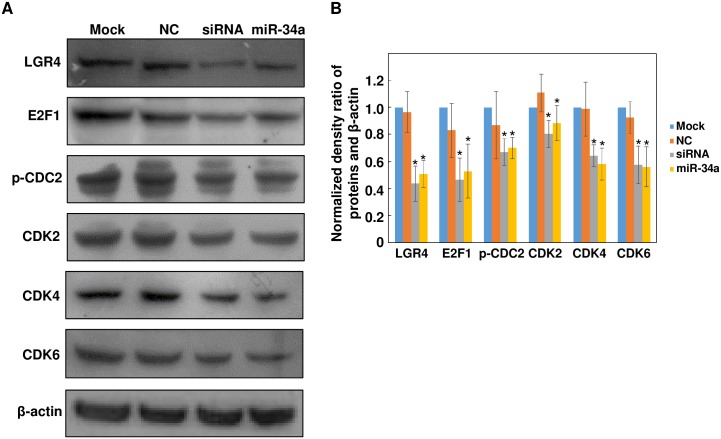
Knockdown of LGR4 downregulates the expression of cell cycle-related molecules reminiscent of miR-34a mimic transfection.(A) After transfection with either LGR4 specific siRNA or miR-34a mimic, ARPE-19 cell lysates were prepared and probed with anti-LGR4, E2F1, p-CDC2, CDK2, CDK4 and CDK6 antibodies. β-actin was probed as a loading control. These results are representative of at least three independent experiments. (B) The band intensity was measured with ImageJ software. The densitometric ratio between proteins of interest and β-actin was calculated and then normalized to the expression level in mock-treated cell. Results were expressed as mean ± SD (n = 3, *p < 0.05).